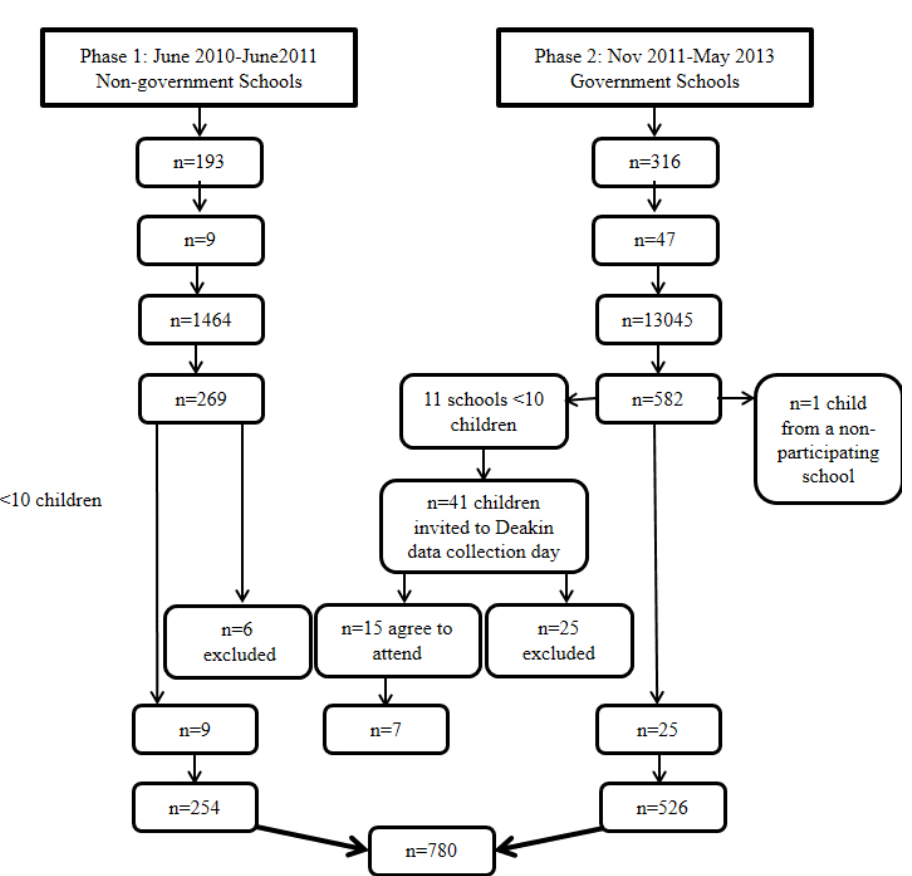
Figure 1. Flow and response rates of participants in the SONIC